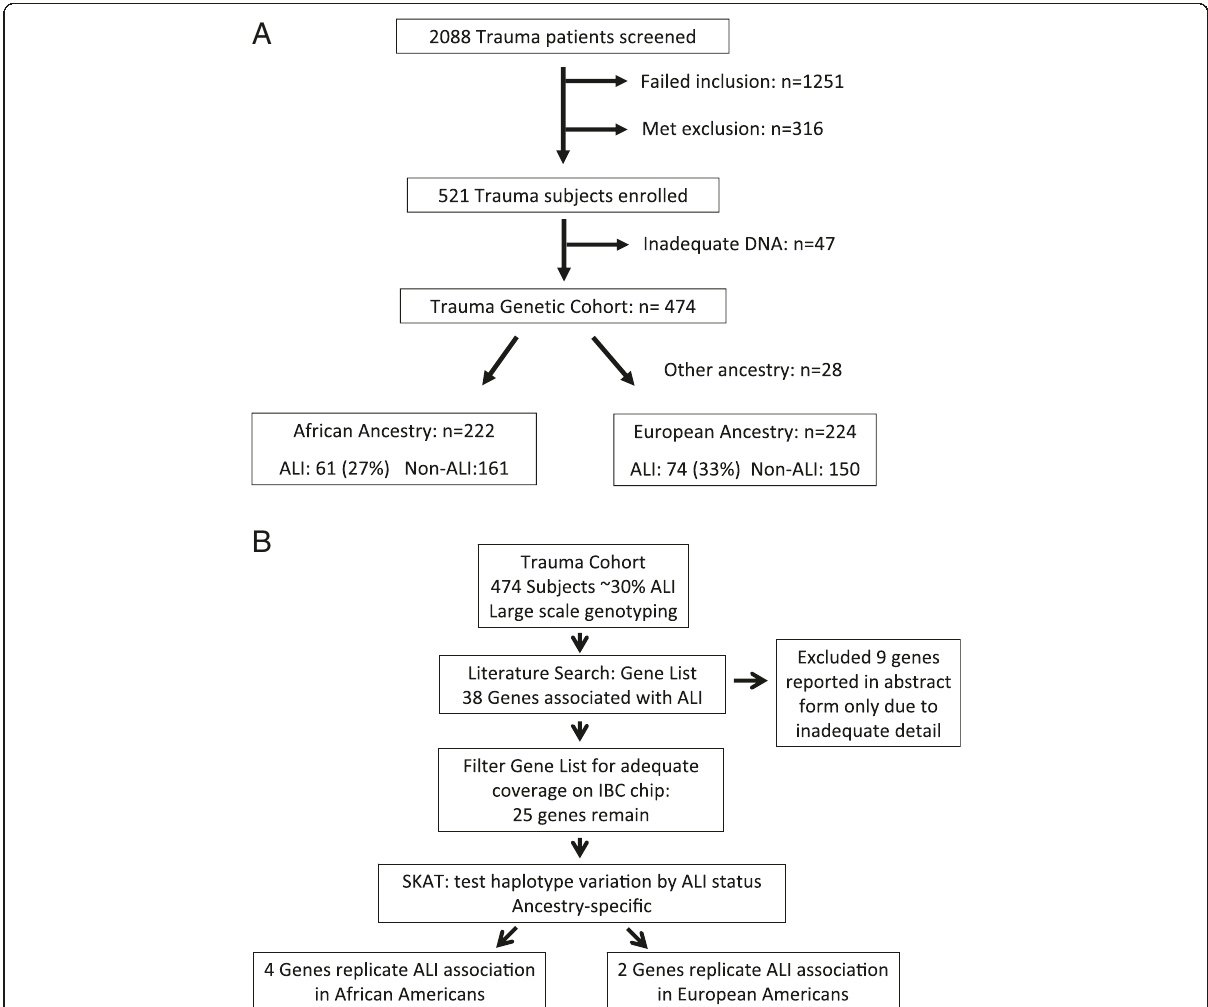
Figure 1 A: Study population. All trauma patients were screened. Eligible subjects were severely injured, with an injury severity score (ISS) ≥ 16, and were admitted to the intensive care unit (ICU). Exclusion criteria included isolated head injury and discharge or death within 24 h. Subjects with adequate DNA were genotyped with the IBC SNP array and were classified by genetic ancestry, African (AA) or European (EA), to create haplotypes for ALI candidate genes. B: Overview of study design and results. Large scale genotyping data was available for 474 subjects in a trauma cohort. A literature search using the terms “ acute lung injury polymorphism, ” “ acute respiratory distress polymorphism, ” or “ genetic association lung injury, ” limited to human species, was performed in May 2011 and returned 38 genes. Nine genes (IL1RN, ORMDL3, THMD, DARC, DIO2, PRKAG2, ISG15, VWF, and BVES) were cited in abstract form only, and were excluded due to lack of detail about the population or genetic variant studied. Of the 29 remaining genes (Table 2), 4 were not covered by the IBC platform. The remaining 25 genes underwent haplotype imputation for each ancestry and the SNP-set kernel association test was implemented for 3 kernel functions: linear, identical by state, and quadratic. Four genes in subjects of African ancestry and 2 genes in subjects of European ancestry replicated their association with ALI in this trauma